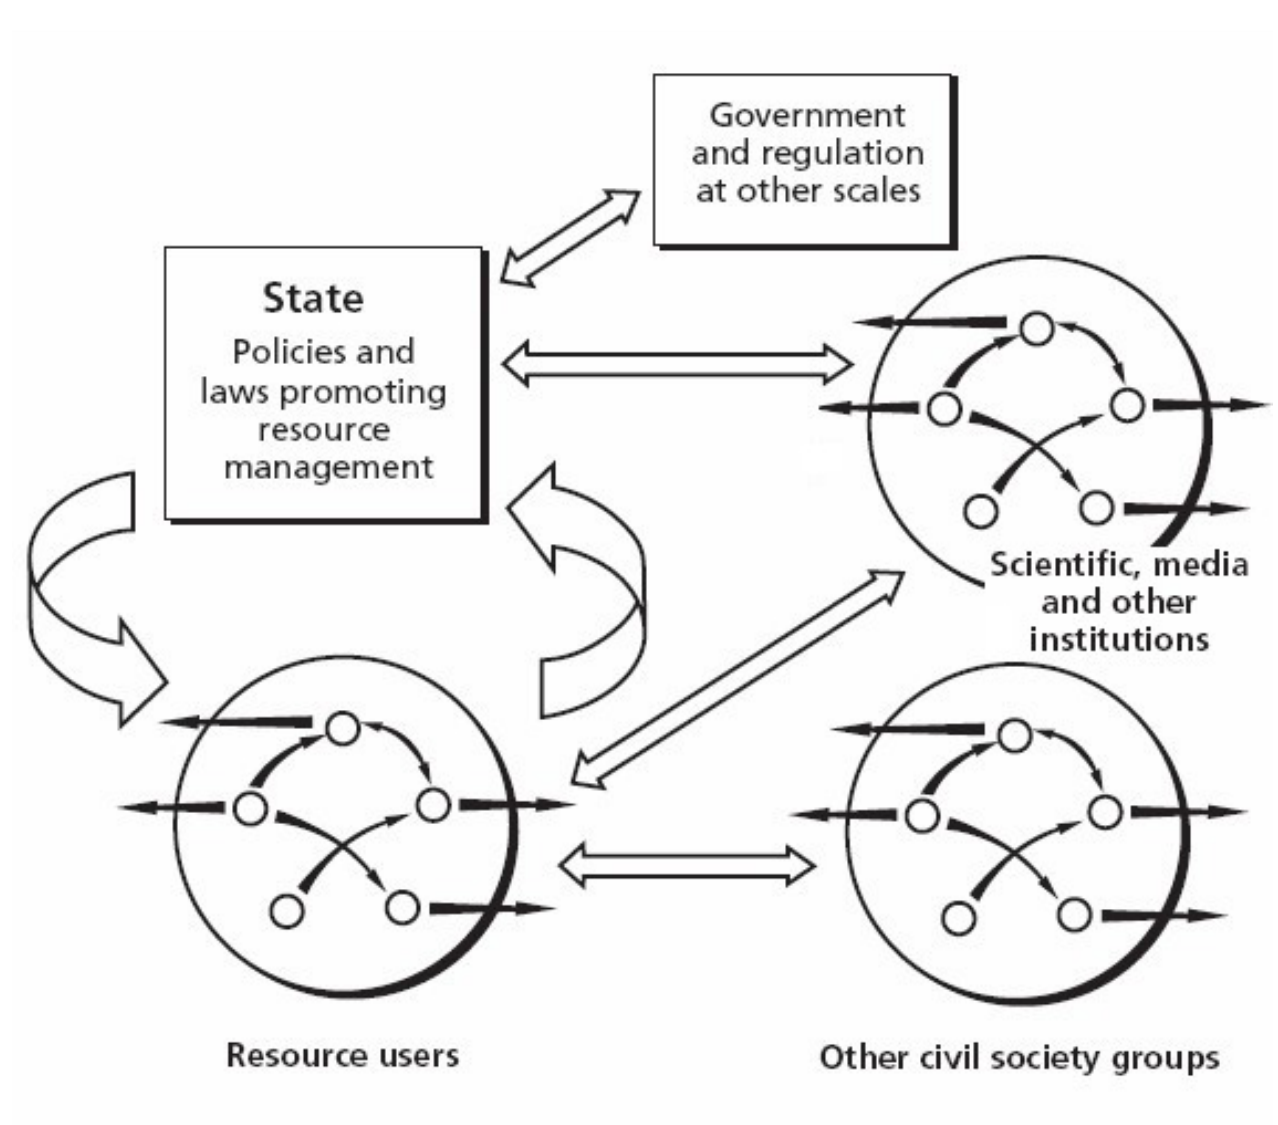
Figure 3 . Cross scale linkages in resource